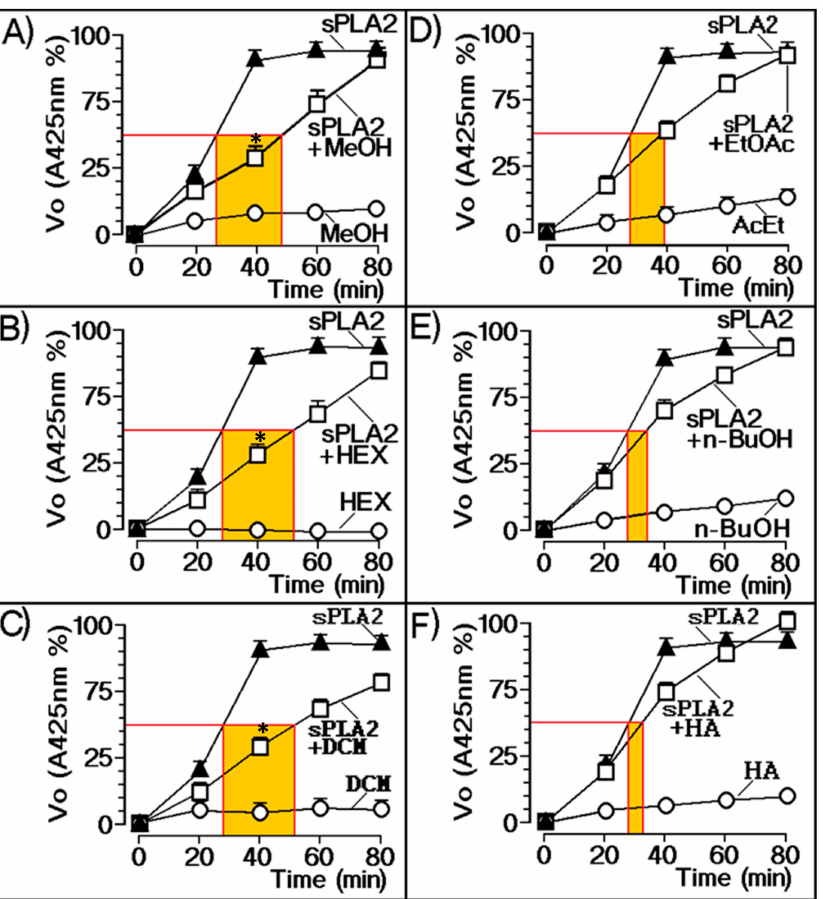
Figure 2. Extract evaluation against enzymatic activity of native sPLA2. ( A ) Methanol (MeOH), ( B ) hexane (HEX), ( C ) dichloromethane (DCM), and ( D ) ethyl acetate (EtOAc) extracts exhibited inhibition of enzymatic activity. ( E ) n -butanol ( n -BuOH) and ( F ) hydroethanolic extracts (HA) showed no significant inhibition of sPLA2 enzymatic activity. Error bars indicate the standard error of the mean (SEM); ∗ p ≤ 0.05 compared with the saline